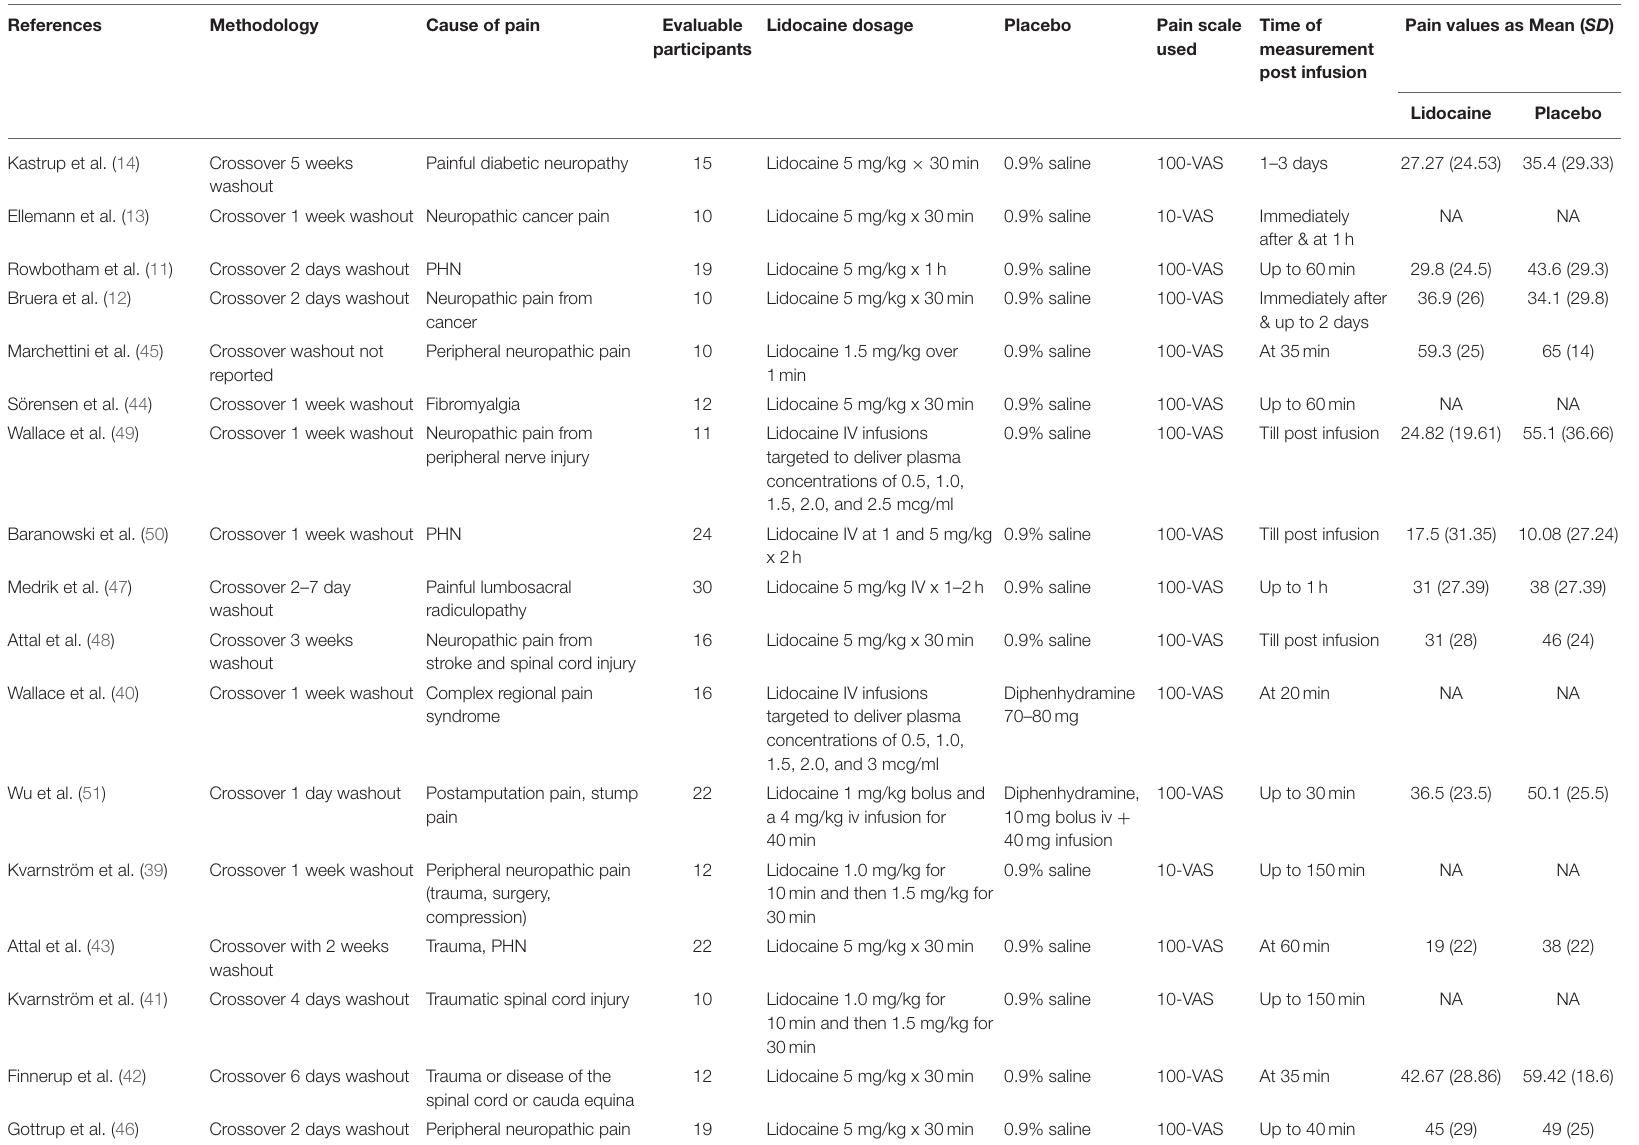
TABLE 1 | Characteristics of included